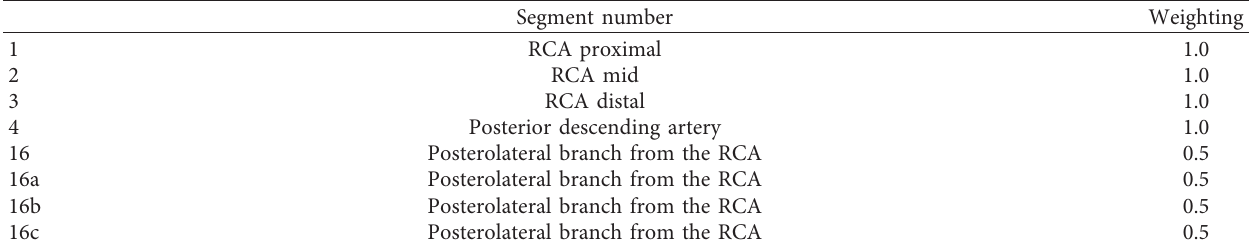
Table 1: Weighting factor assignment to the RCA system for the right dominance in the SYNTAX score. Segment number